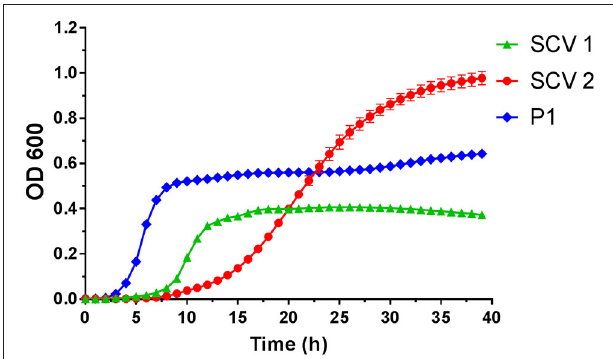
FIGURE 2 | Growth curves of small colony variant SCV1 (green triangles), SCV2 (red dots) and parent strain P1 (blue diamonds).